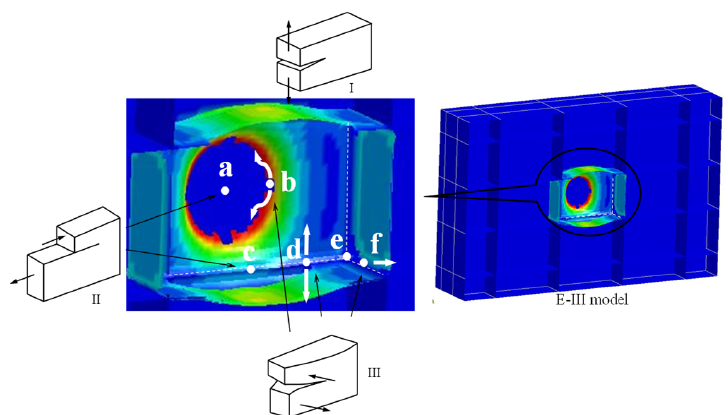
Figure 8. Type of openings.